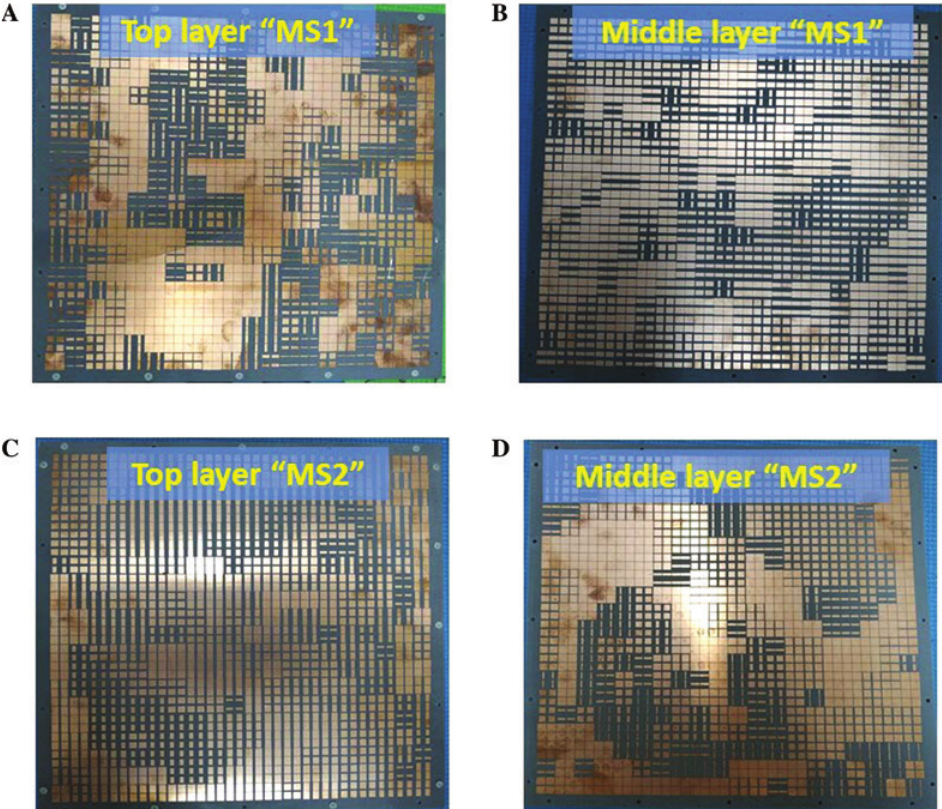
Figure 7: (A), (C) The top and (B), (D) middle layers of the two different fabricated meta-holograms labeled as MS1 (top row) and MS2 (bottom